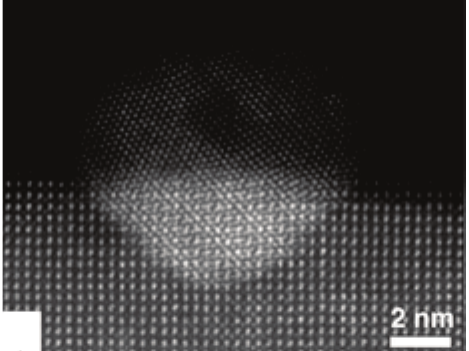
Figure 7. TEM image of a Pd particle partially embedded in the surface of a LaFeO